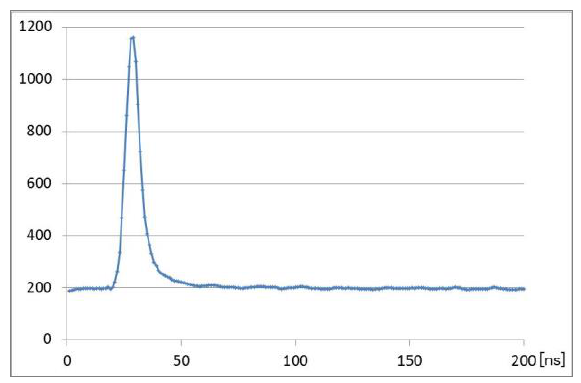
Figure 7. Waveform of Sudajii (single points)